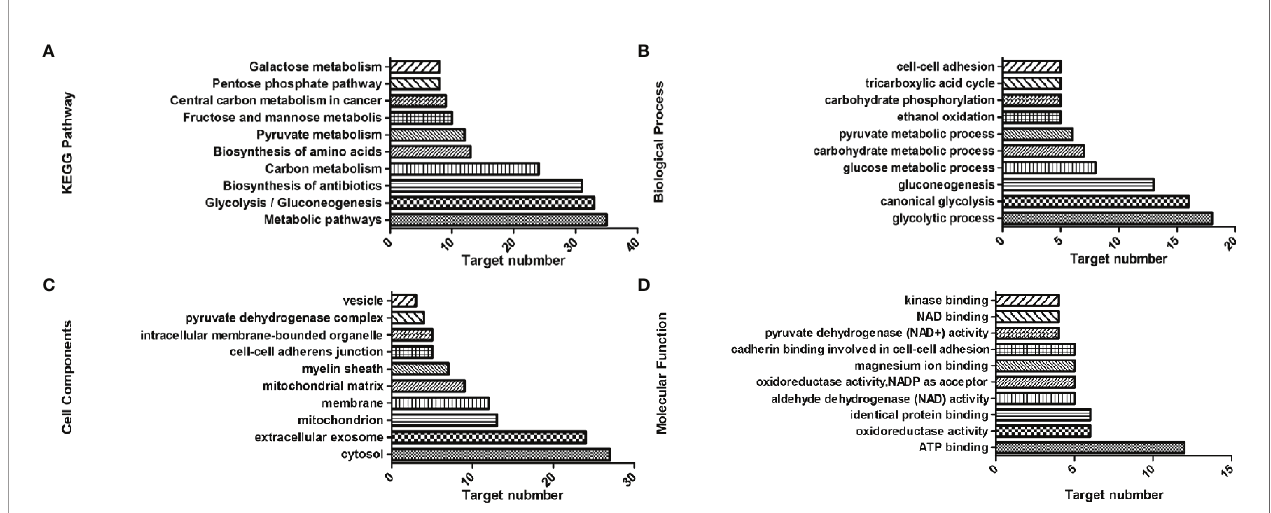
FIGURE 2 | Top 10 components of the KEGG pathway and GO enrichment analyses. (A) KEGG pathways. (B) Biological process. (C) Cell components. (D) Molecular